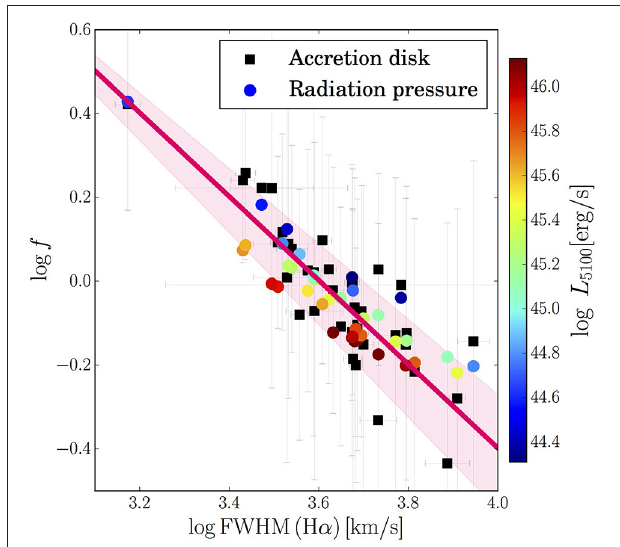
FIGURE 3 | Radiation pressure in a gravitationally bound BLR. The observed virial factor vs. FWHM obs for the H α line is shown (black squares). The magenta line is the derived relation f = (cid:16) FWHM obs ( H α)/ 4,000 kms − 1 (cid:17) and the width of the shadowed region accounts for the uncertainties in that relation. The filled points represent the modeled f rad from the best fit model for radiation pressure in a gravitationally bound BLR. The color of the points scales with the measured monochromatic luminosity at 5,100Å ( L 5100 ) for each object, as indicated by the color bar. Redder (bluer) points correspond to larger (smaller) values of L 5100 . As can be observed, the model predicts that the scatter in f rad (colored points) is driven by L 5100 (see Equation 8). This dependence is not seen in our data (black squares) as shown in the right panel of Figure 1 . Nevertheless, the relatively large errors in f AD and the weak dependence of f rad in L 5100 may probably hide the expected dependence from this radiation pressure